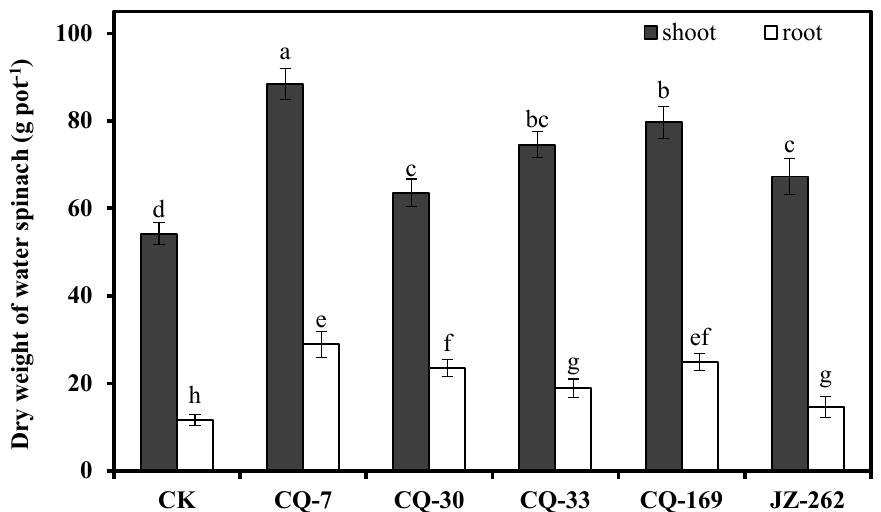
Figure 4. E ff ects of strains on the dry weight of water spinach in the 5 mg L − 1 Cd 2 + and 20 mg L − 1 Pb 2 +